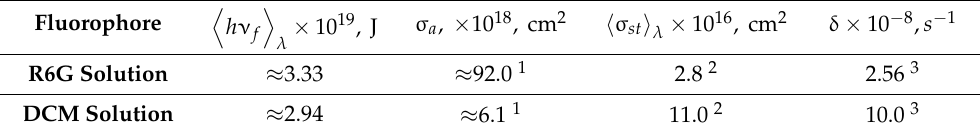
Table 2. Absorption and emission parameters of the used fluorescent